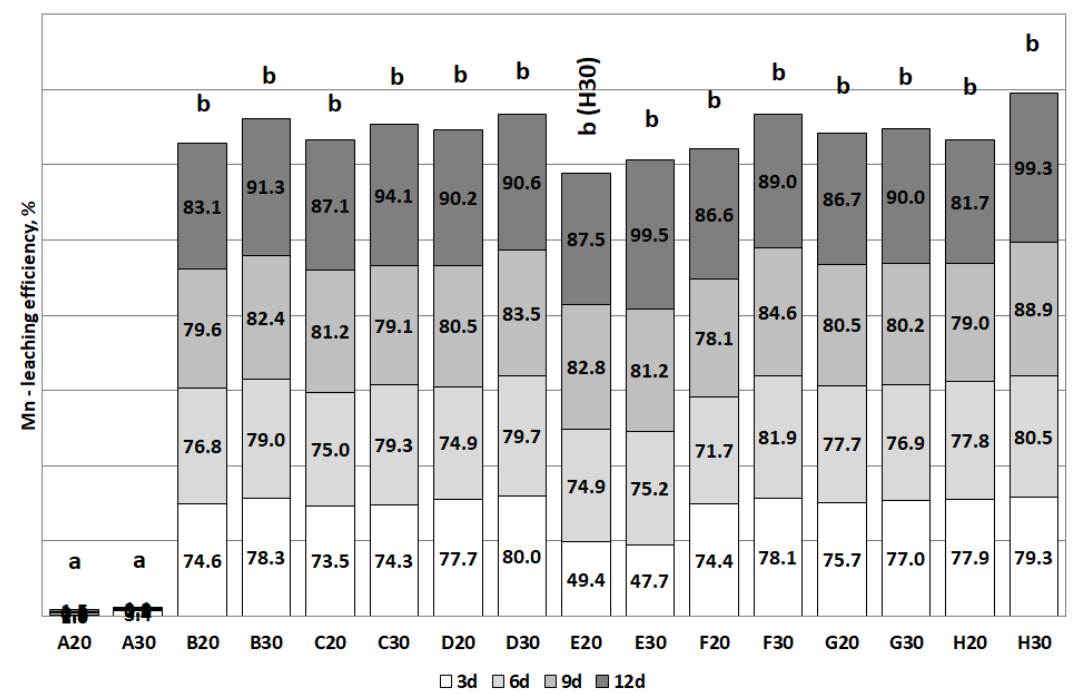
Figure 13. Bioleaching efficiency of Mn during the experiment (Statistical groups a and b ).